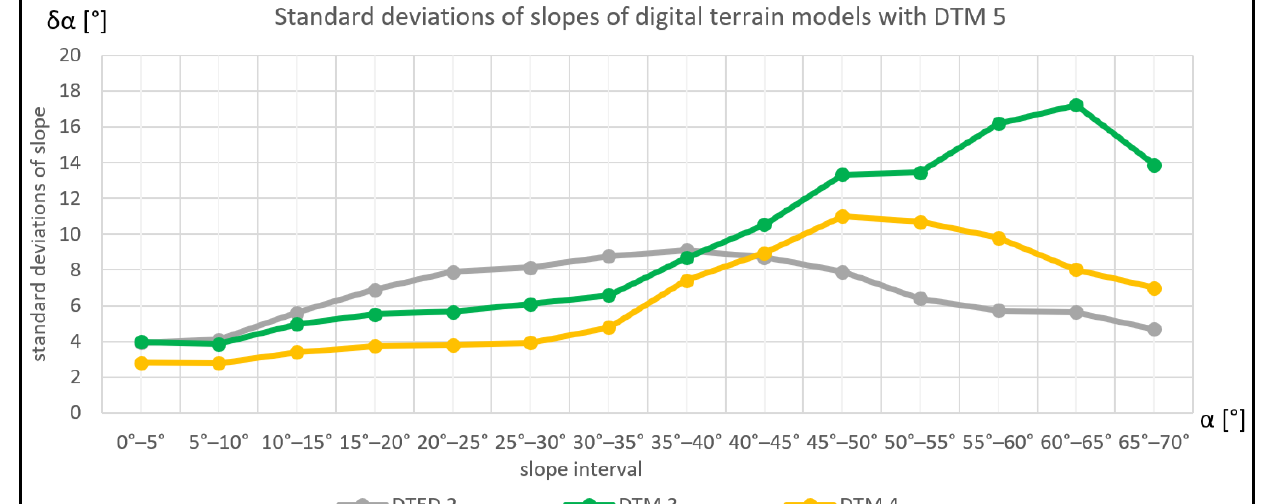
Figure 7. Graph comparing standard deviations of slopes of different terrain models (DTM 5, DTM 4,